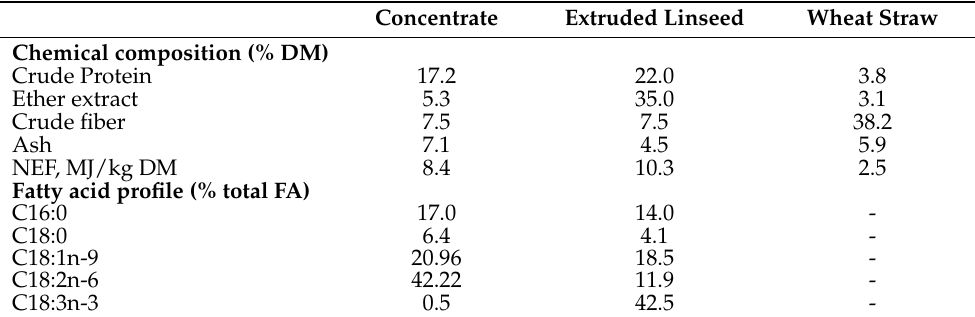
DM, dry matter; NEF, Net energy for fattening calculated according to INRA 2018 standard for ruminants